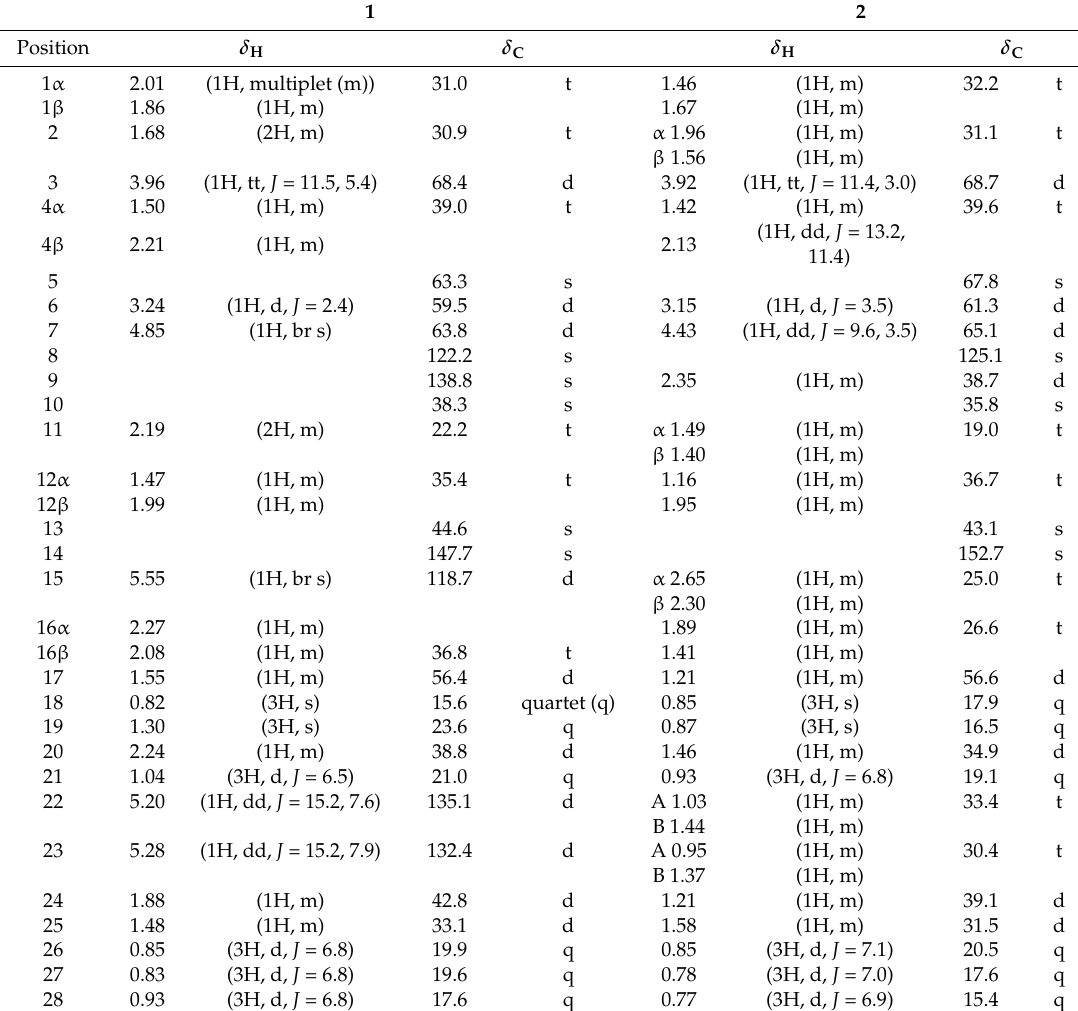
Table 1. 1 H and 13 C NMR Data for Compounds 1 and 2 in CDCl 3 ( δ in ppm; J in